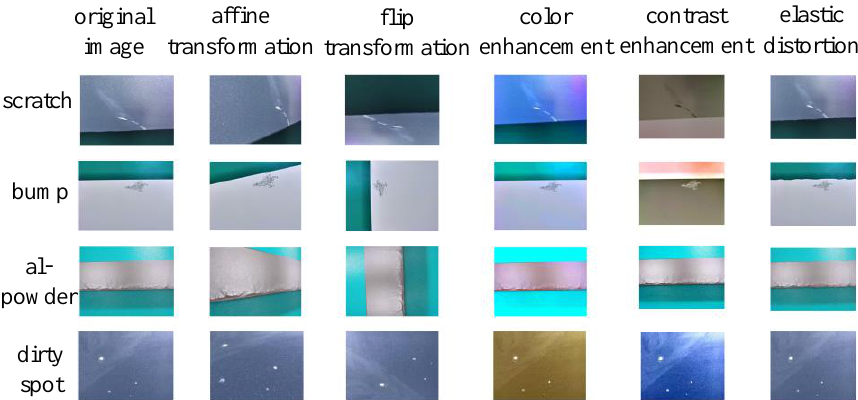
Figure 8. Examples of surface defects of aluminum profiles.